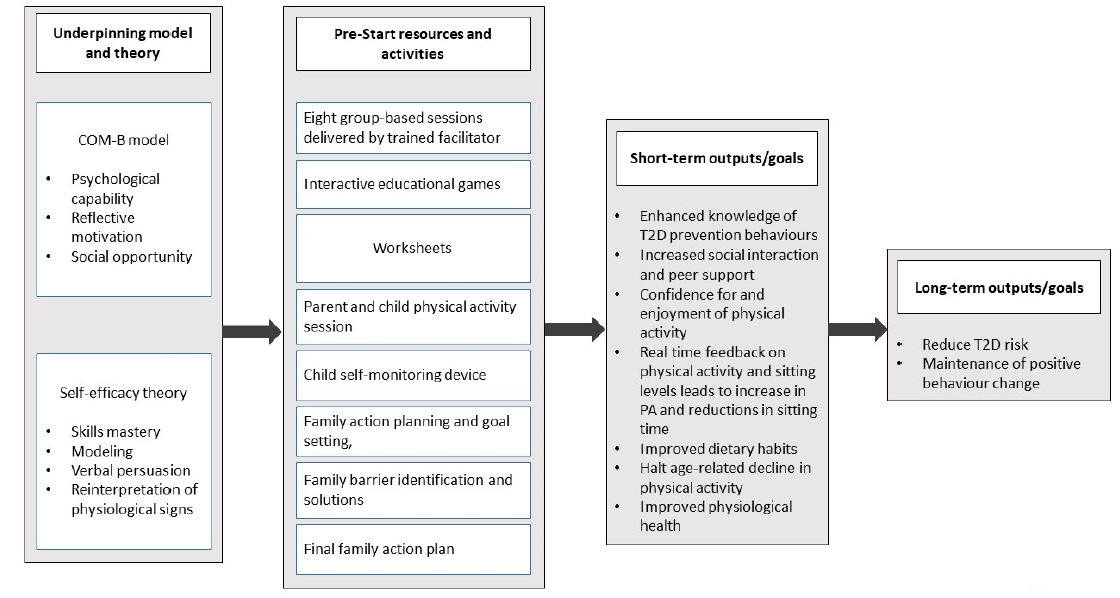
Figure 1. PRE-STARt logic model. This figure has been uploaded separately to improve quality.